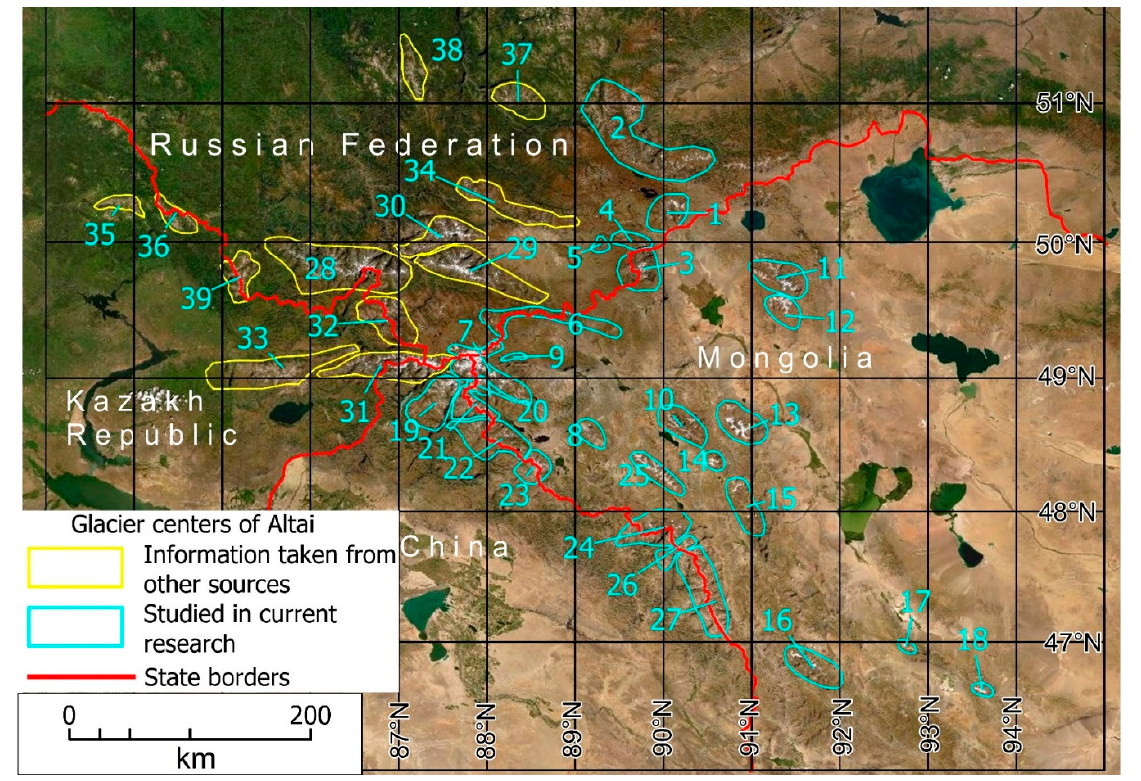
Figure 1. Glacial centers of Altai. 1—Mongun-Taiga, 2—Shapsalsky ridge, 3—Ikh Turgen, 4—